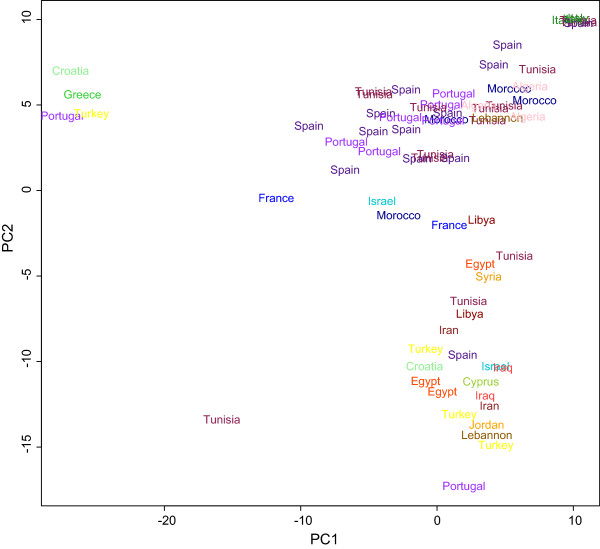
Structure plot of a) tetraploid wheats in the K = 2 model and b) durums only in the K = 4 model. Each accession is depicted by a vertical line segmented into K coloured sections. The length of each section is proportional to the estimated membership coefficient (Q) of the accession to each one of the K number of clusters. Accessions are assembled by a) taxon and b) country of origin.